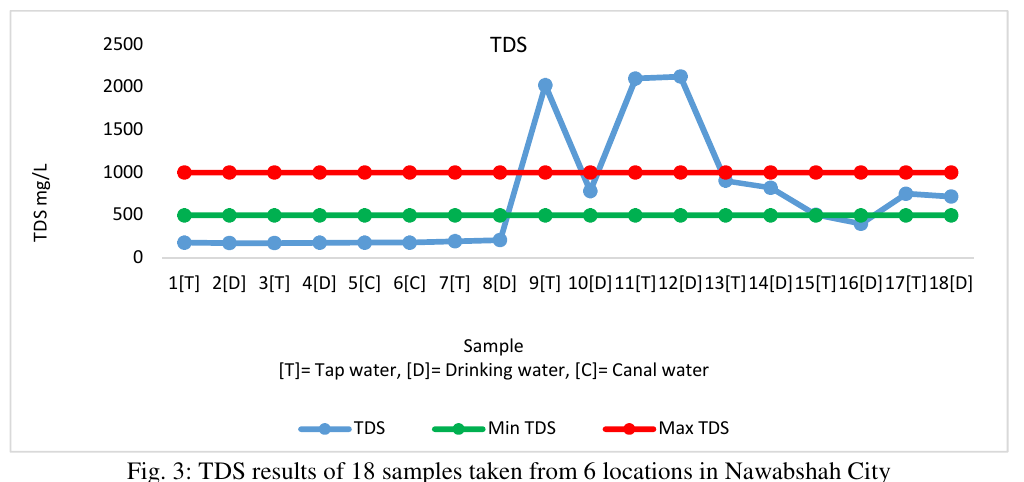
Fig. 3: TDS results of 18 samples taken from 6 locations in Nawabshah City